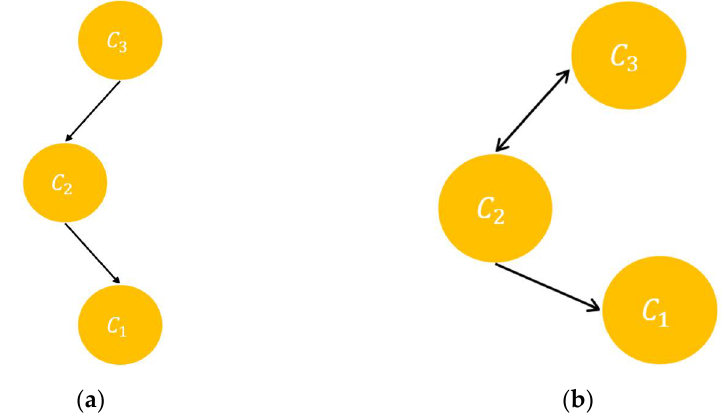
Figure 7. Access policies. ( a ) hierarchical classes; ( b ) flexible classes. Table 2. The parameters of C j for Figure 7b.